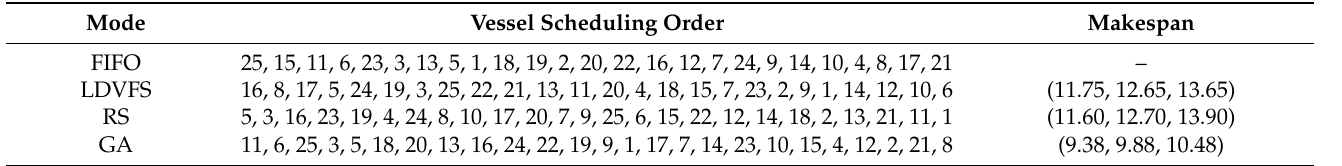
Table 5. Comparison among the different scheduling rules (Case_25_1). Mode Vessel Scheduling Order